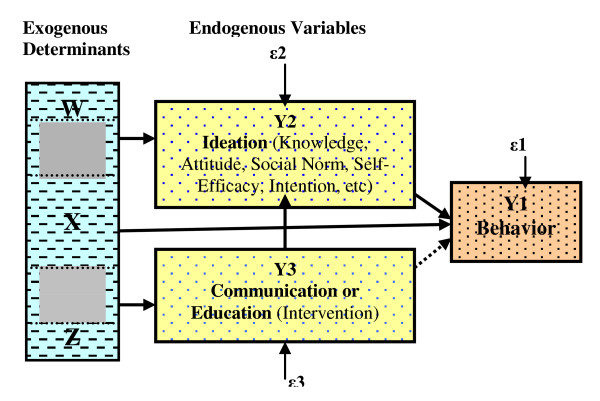
A Model of Strategic Communication and Behavior Change.